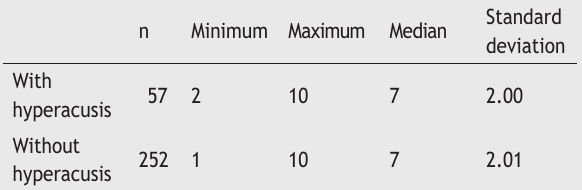
Table 2 Comparison of the degree of tinnitus annoyance among patients according to the presence of